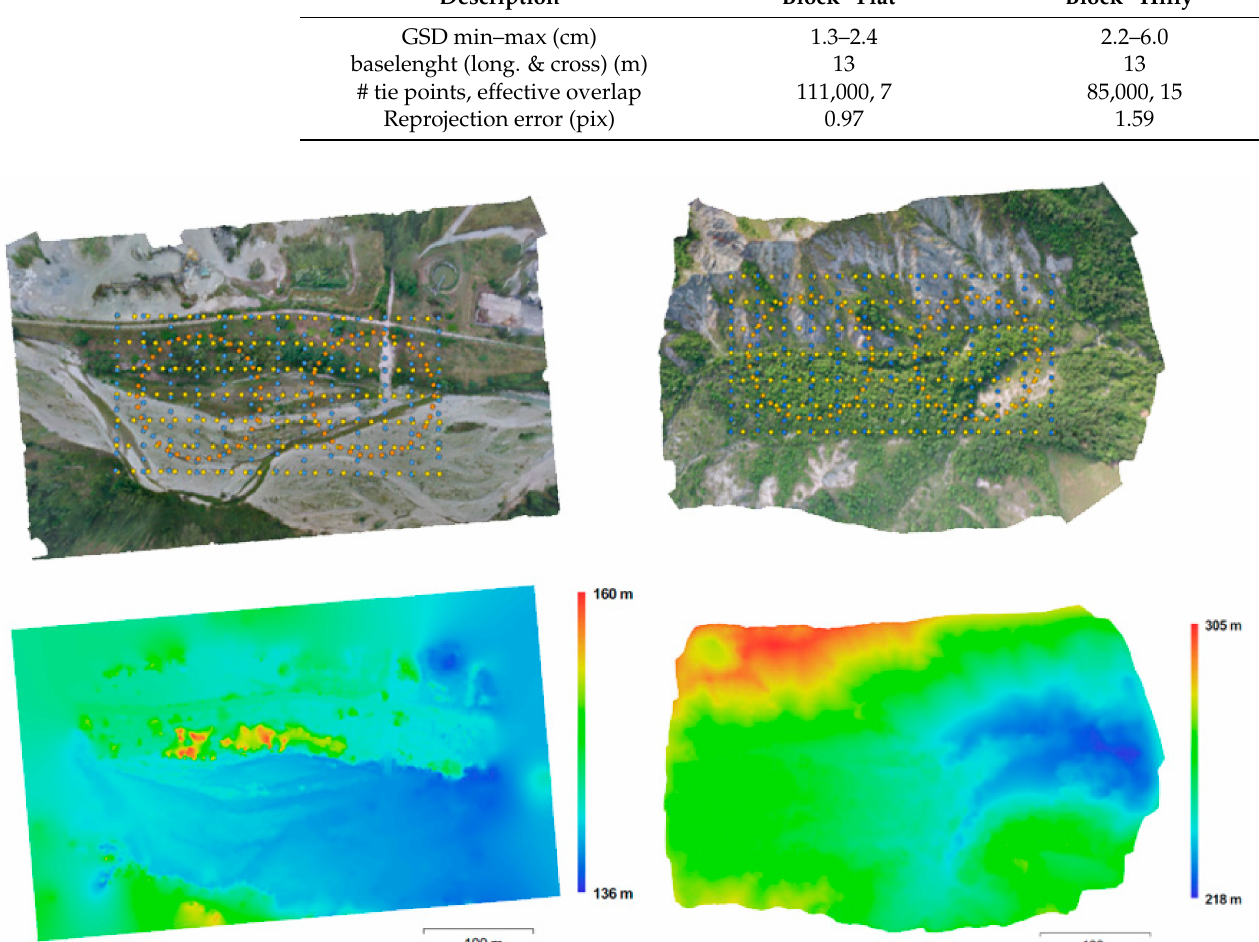
Figure 1. The top row shows the orthophoto of the Flat ( left ) and Hilly ( right ) areas, with superimposed the camera stations locations, colour-coded per strip type: longitudinal (yellow), cross (blue), oblique (orange). The bottom row shows the DEM generated from the sparse tie points.